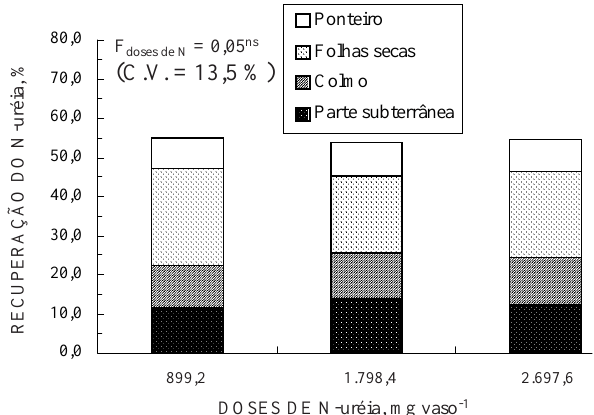
Figura 5. Recuperação do N-uréia aplicado ao solo na cana-planta (os valores de teste F e de C.V. referem-se à planta